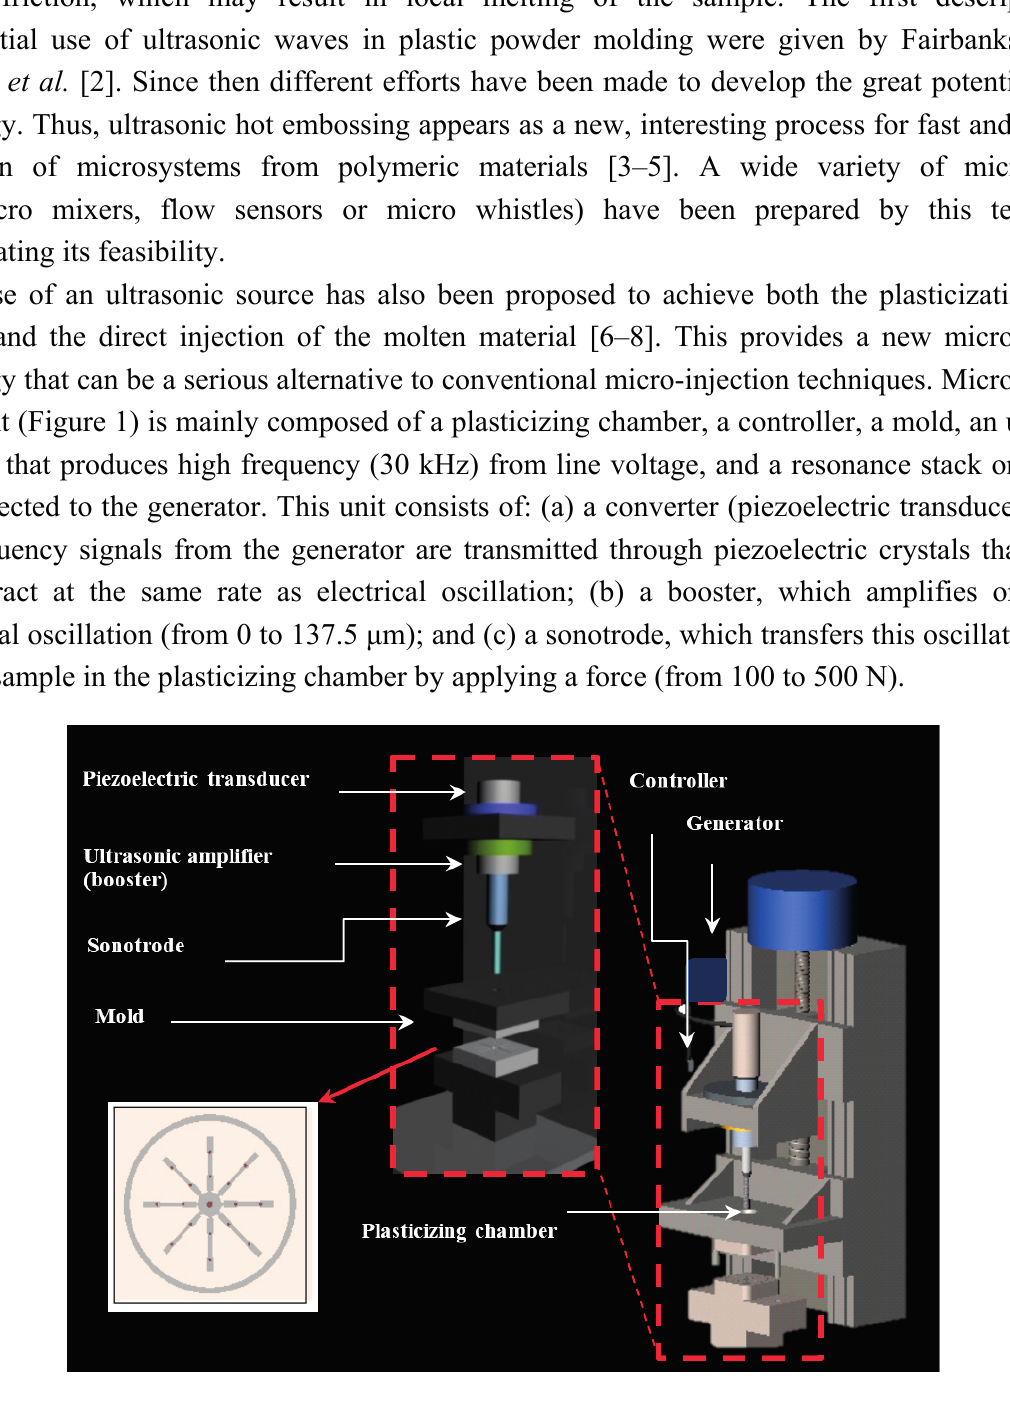
Figure 1. Scheme of the main parts of the ultrasound micro-molding